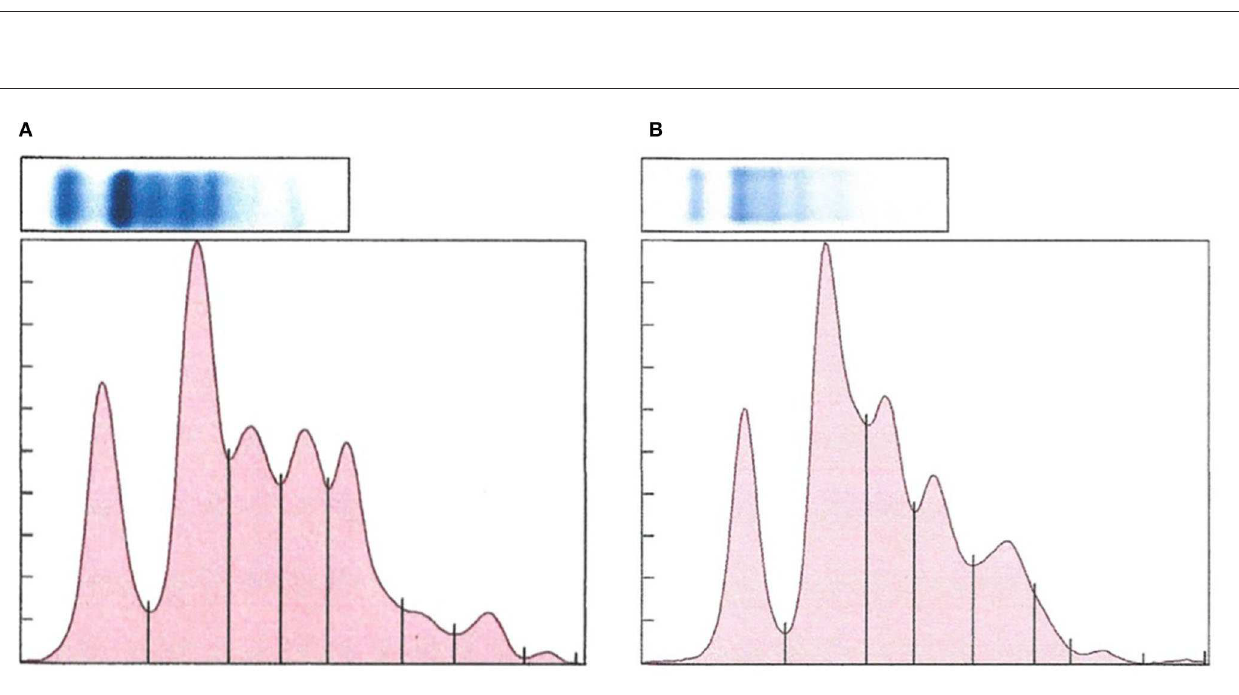
FrontiersinVeterinaryScience